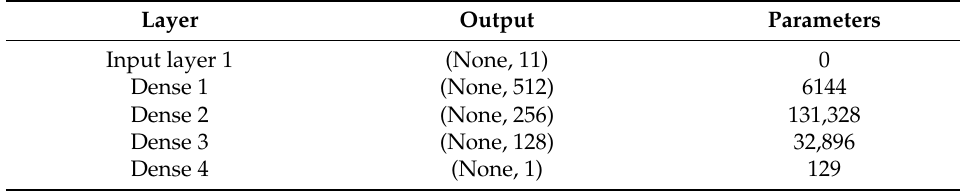
Table 5. GAN and WGAN models discriminator network.